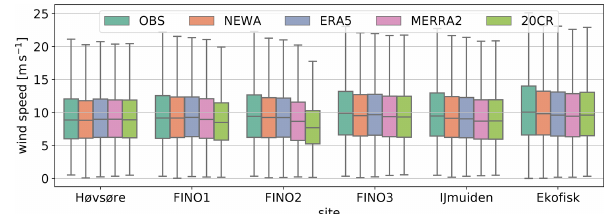
Figure 2. Comparison of the observed and reanalysis-derived wind speed statistics at the six observed sites in Fig. 1a. The reanaly- sis and observations are synchronized in time and thus are at a 3h frequency. The boxplots show the “minimum”, first quartile (Q1), median, third quartile (Q3), and “maximum” of each distribution.